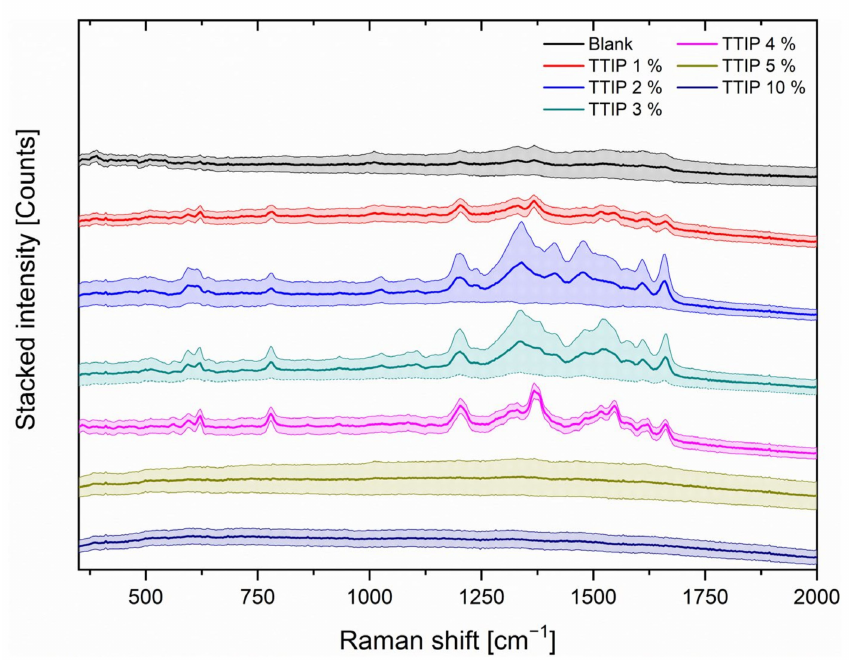
Figure 3. Mean Raman spectra as well as the standard deviations of a 3 by 3 mappings with the 638 nm Laser with 35 mW, 1 s integration time and 10 spectra of each mapping position of the SERS substrates with different concentration of TTIP (coloured lines) and dried under ambient air for 24 h. Additionally an untreated aluminium substrate (AuNPs, black line) is used as a reference. All substrates were coated with AuNPs suspension and 2 µ L of rhodamine 6G (R6G) (10 − 6 mol/L) were applied as a model analyte.